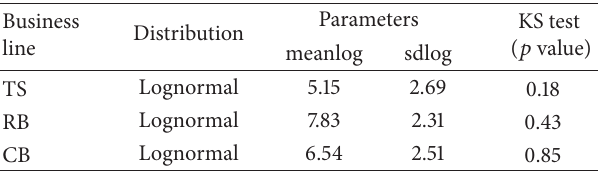
Table 1: The parameters of loss severity distribution for different business lines.